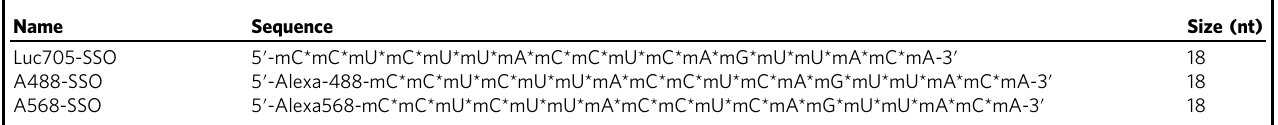
Table 1 Nomenclature, sequence, chemical modi fi cations, and size of